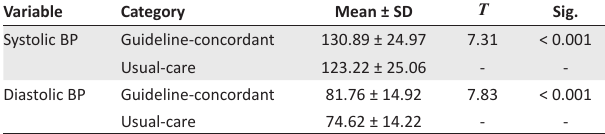
FIGURE 2: Comparison of usual-care and guideline-concordant blood pressure measurement. TABLE 2: Comparison of means of blood pressure (systolic and diastolic) between guideline-concordant and usual-care blood pressure measurement protocols using the paired T -test.